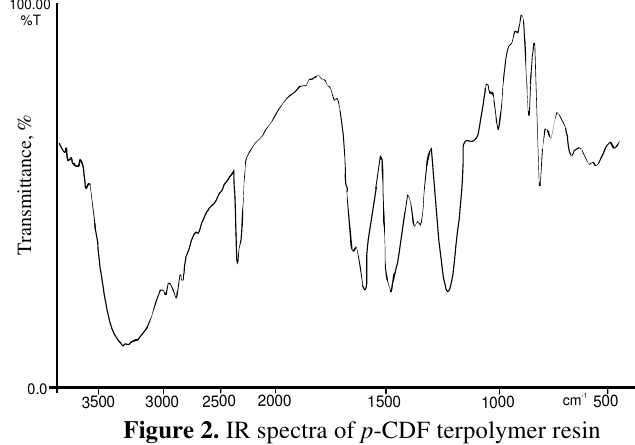
Figure 2. IR spectra of p -CDF terpolymer